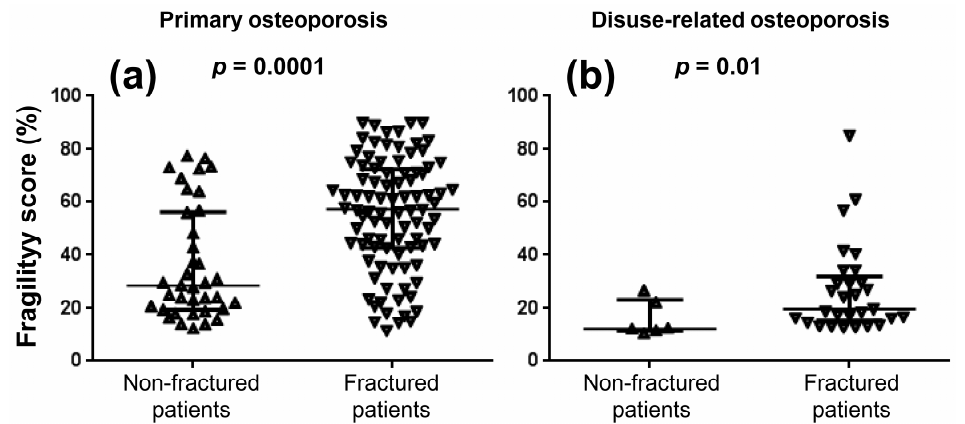
Figure 4. Comparisons of fragility score values between non-fractured and fractured patients with primary (panel ( a )) and disuse-related osteoporosis (panel ( b )).